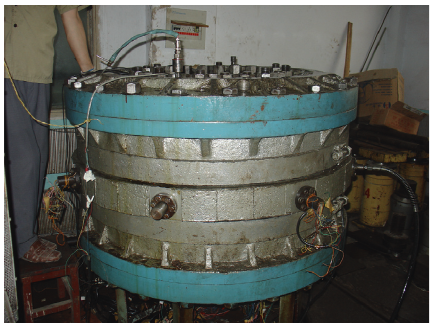
Figure 2: Shaft lining model loading